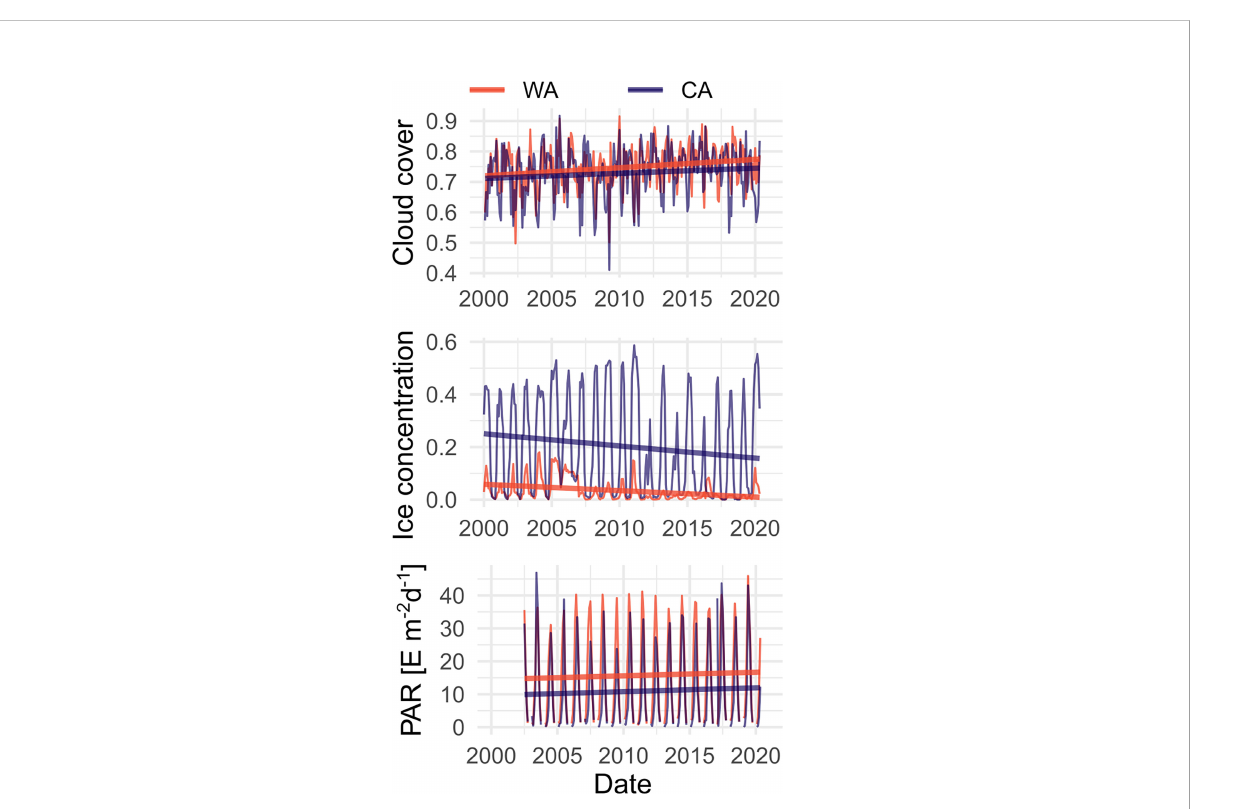
FIGURE 2 Spatially averaged cloud cover, monthly ice concentration (a fraction of water surface covered by sea ice according to the MERRA-2 model) and Photosynthetically Active Radiation (PAR) in areas surrounding study sites: Warm Arctic (WA) in West Spitsbergen and Cold Arctic (CA) in East Spitsbergen in years 2000-2020 (data used for plotting were obtained using the Giovanni online data system, developed and maintained by the NASA GES DISC). Thick lines show the trend of the value in each